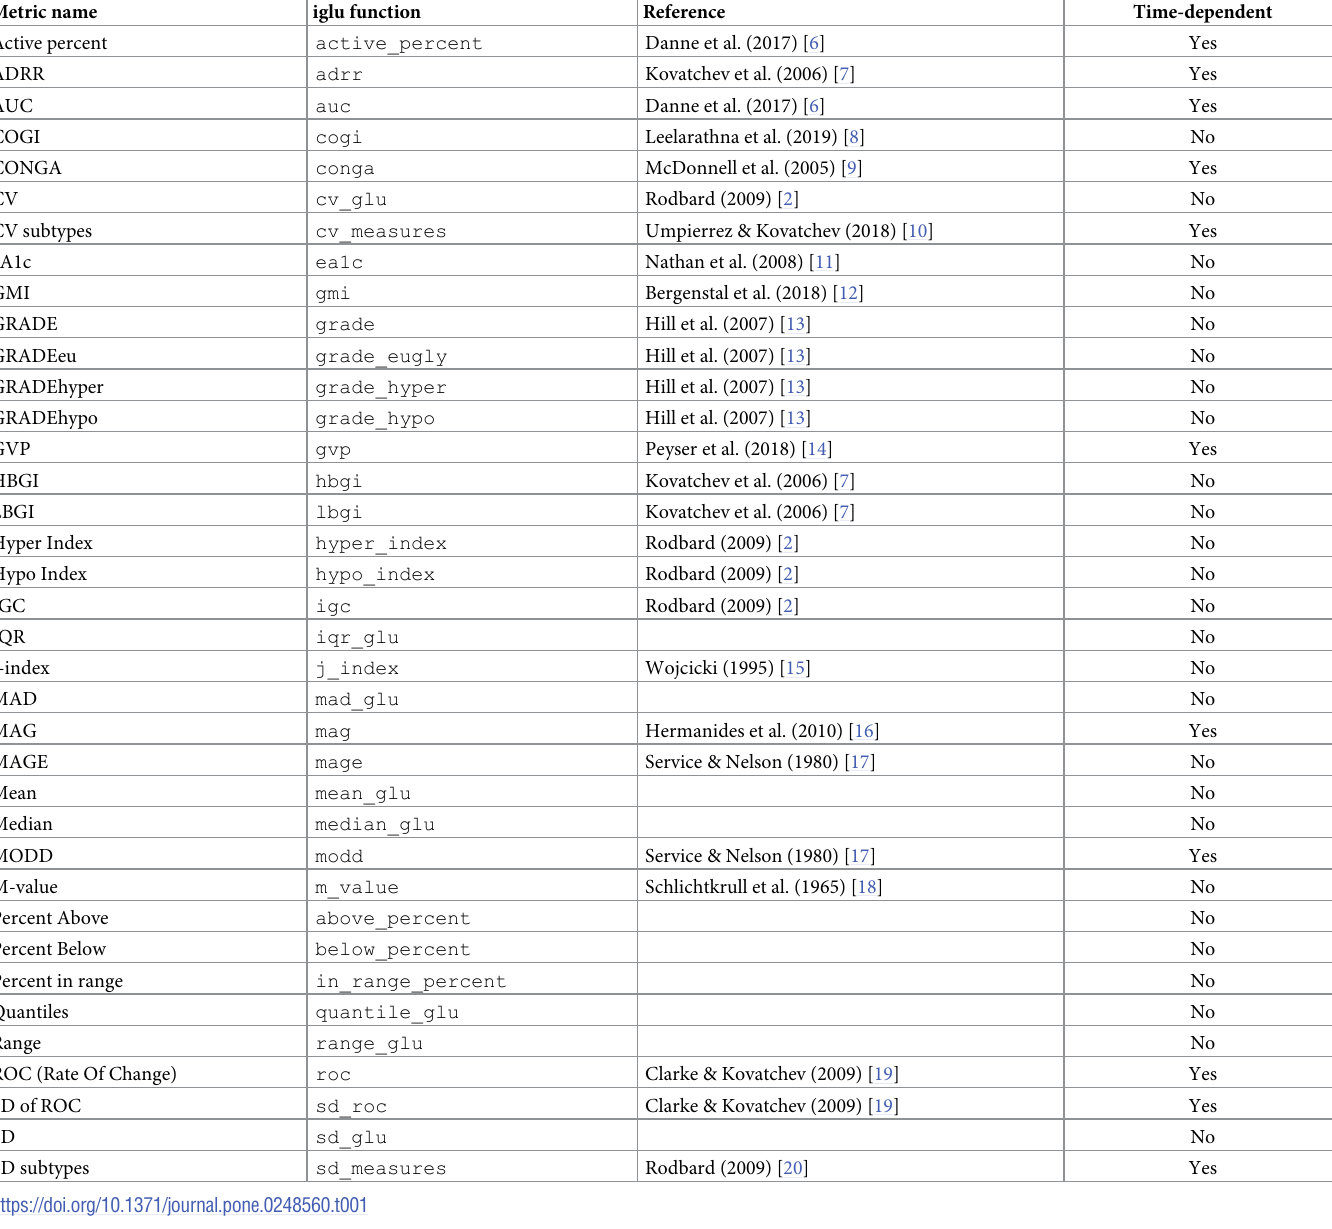
Table 1. Summary of CGM metrics implemented in